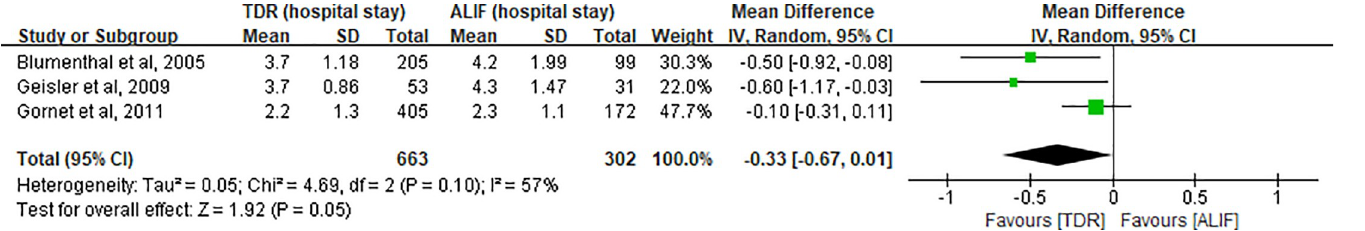
Fig 3. Forest plot for duration of hospitalization. df = degrees of freedom, and IV = Inverse Variance.